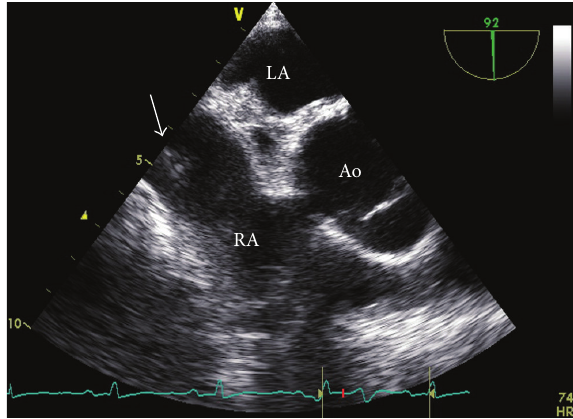
Figure 4: The postprocedural transesophageal echocardiogram (TEE) findings showed the residual floating structure in the RA (arrow), suggesting the tissue of Chiari’s network. Ao: ascending aorta, LA: left atrium, and RA: right